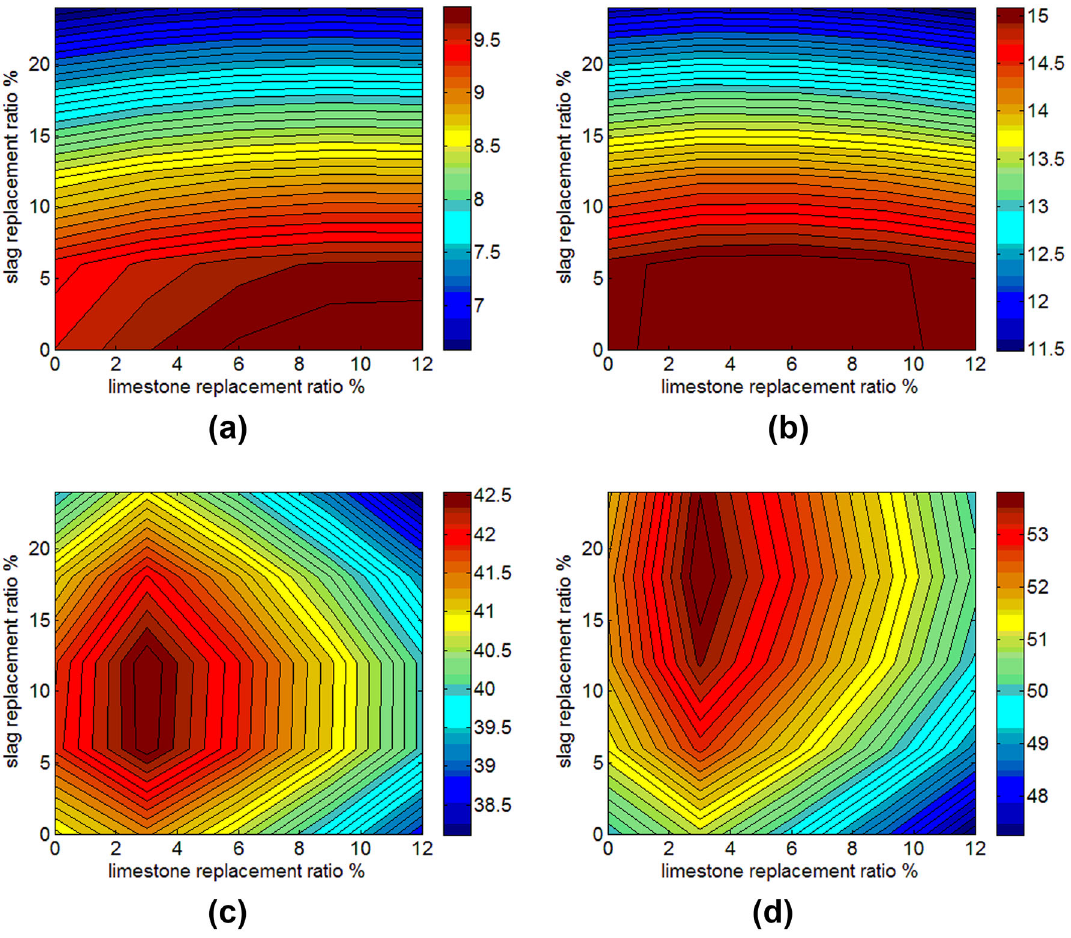
Fig. 11 Isoresponse curve for compressive strength. a 0.5 day, b 1 day, c 28 days, d 180